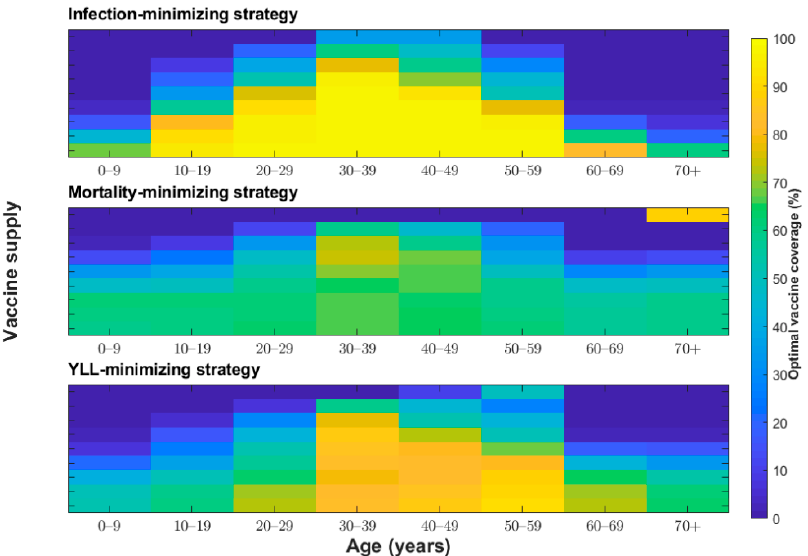
Figure 7. Impact of lower basic reproduction number on the proportion of individuals vaccinated from each age group ( x -axis) to minimize three healthcare measures (i.e., total number of infections, total number of deaths, and the years of life lost) under various vaccine coverage levels ( y -axis). Vaccine efficacy of 90% and a basic reproduction number ( R 0 ) of 1.5 are assumed.